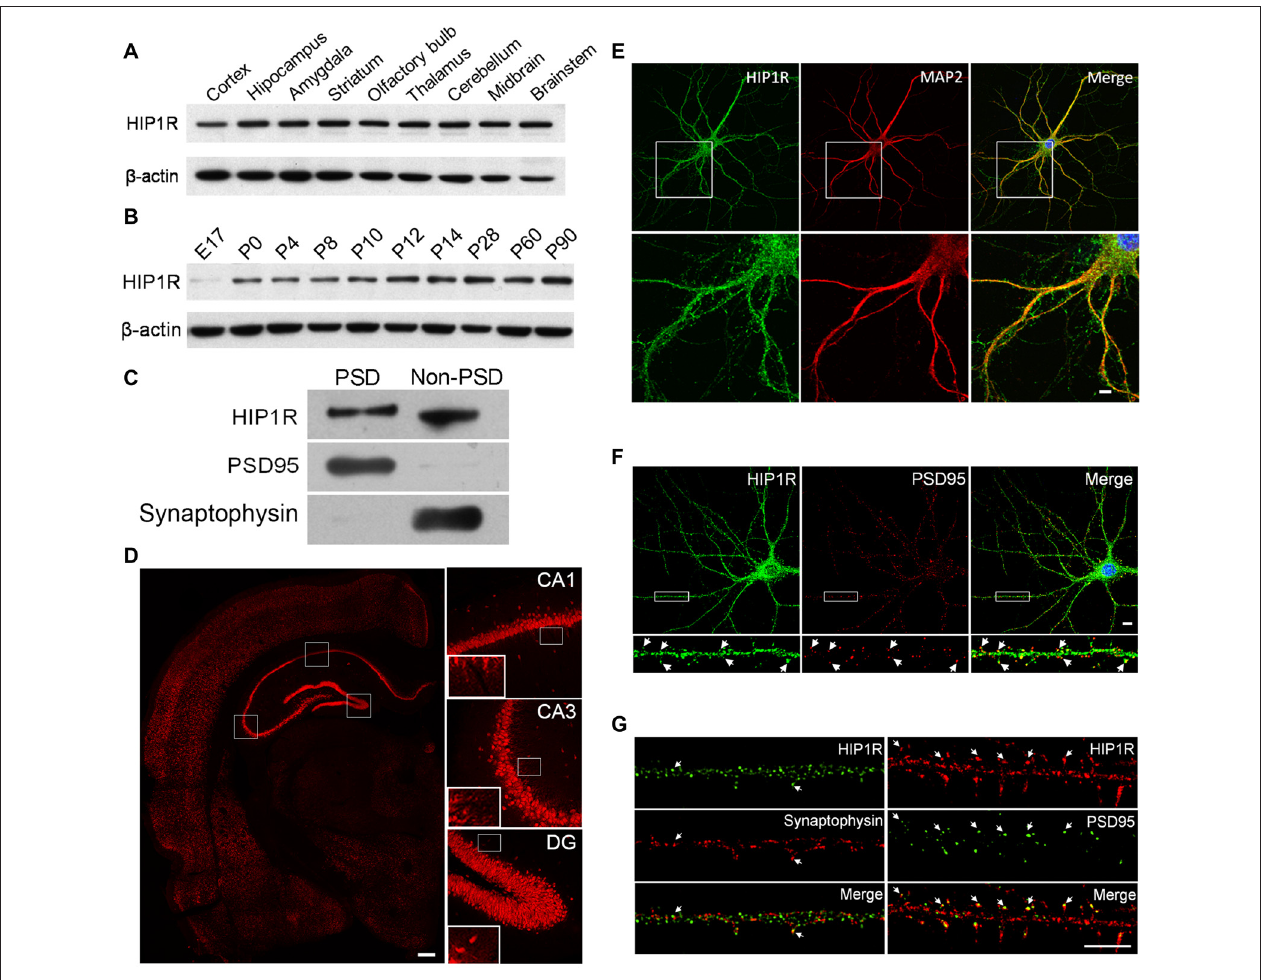
FIGURE 1 | Huntingtin-interacting protein 1-related (HIP1R) expression in rat brain tissues and cultured hippocampal neurons. (A–C) Western blotting showed that HIP1R was highly expressed in different brain regions of rats (A) expressed with a gradual increase in the hippocampus during postnatal development (B) and located partially in the postsynaptic density (PSD) fraction (C) . (D) Immunohistochemical staining of the hippocampus revealed a strong immunoreactivity of HIP1R in the pyramidal layer in the CA1 and CA3 regions, and the dentate granule cell layer. The insets showed that HIP1R was also distributed on the CA3 and CA1 stratum radiatum. Scale bar = 200 µ m. (E) Co-immunofluorescence staining of primary cultured hippocampal neurons at days in vitro 21 (DIV21) showed that HIP1R exhibited small punctate structures on the soma and along dendrites marked by anti-MAP2 antibody. Scale bar = 10 µ m; and (F,G) HIP1R puncta were partially colocalized with PSD95, but barely with synaptophysin (arrows). Scale bar = 5 µ m. Uncropped images of blots are shown in Supplementary Figure S1.1A–C